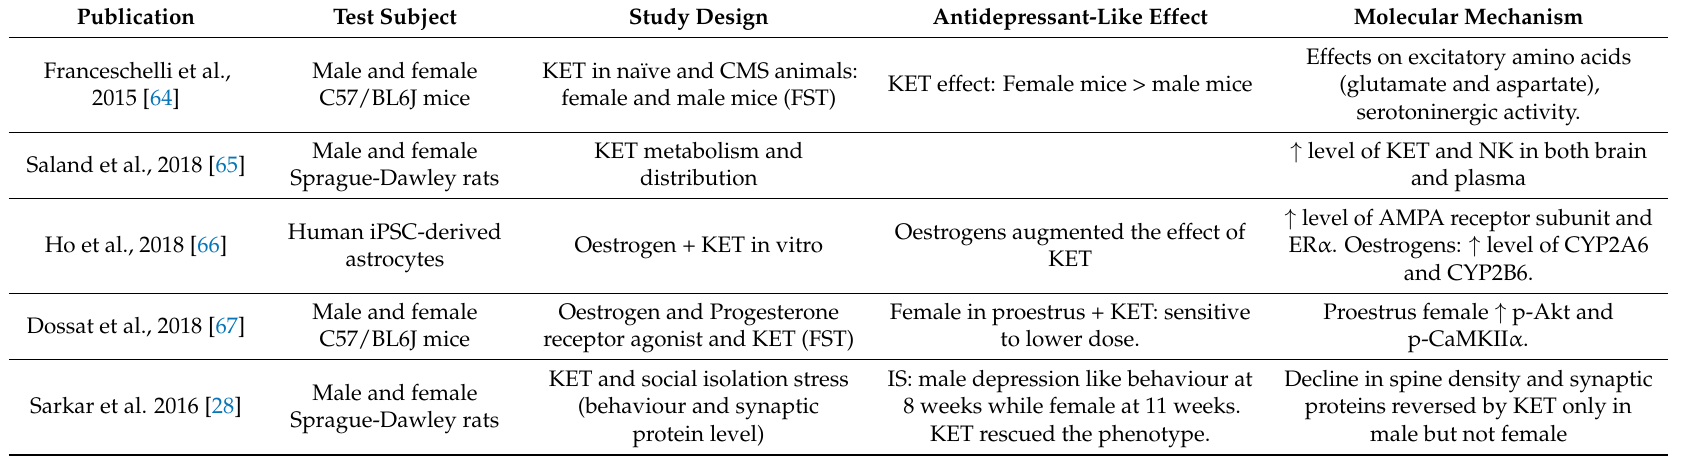
Table 1. In vitro and in vivo experiments using ketamine treatment.